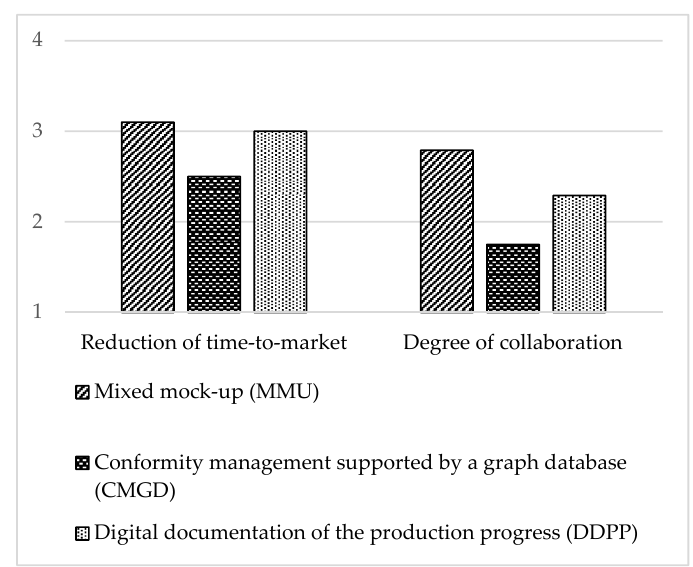
Figure 3. Means of the criteria on the organizational dimension with statistically significant differences between the three scenarios.